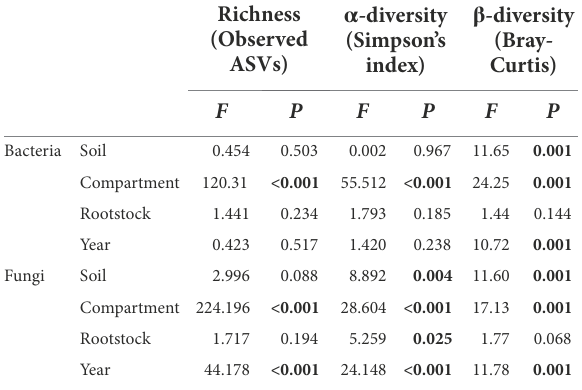
TABLE 2 Effect of soil type (S, AS), compartment (bulk, rhizosphere, and roots), rootstock genotype (1103P and RGM), and year of the experiment (2019, 2020) on richness, α -diversity, and β -diversity of bacterial and fungal communities in the dataset from greenhouse experiments.